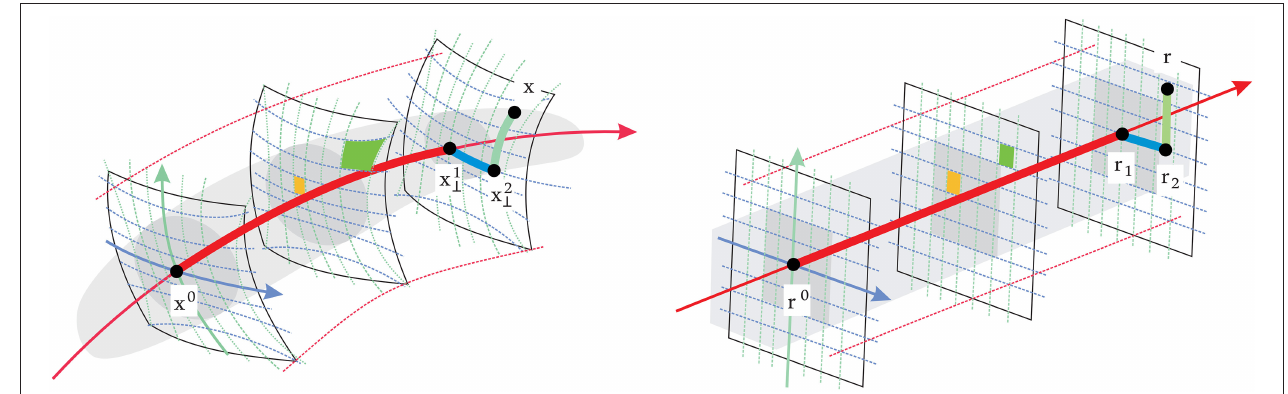
FIGURE 11 | The SPCA leading idea is removing redundancies by unfolding the dataset along the first and secondary Principal Curves (PCs) and performing local equalization along the way. Here the first PC (Hastie and Stuetzle, 1989) is in bold red and the secondary PCs (Delicado, 2001) are in green and blue. Left plot represents the input domain x and right plot represents the response domain r. Gray regions represent the underlying PDFs. As in Self Organizing Maps (Kohonen, 1982), a curvilinear lattice is assumed (thin red, blue, and green curves). However, unlike in SOM, the computation of the whole lattice is not needed: to transform a certain x just the path in bold style, made of segments of PCs, is required. Moreover, the specific resolution per dimension emerges from data: the PDF-based metric in SPCA implies that highly populated regions in the input are expanded in the response while lower density regions are shrunk (e.g., orange and green areas) . Given an origin, x o , in the first PC (red line) and some point of interest, x, the response for the point of interest is given by the lengths along this path: the first PC in red, the secondary PC in blue in the orthogonal subspace at x 1 ⊥ , which is the (geodesic) orthogonal projection of x on the first PC, and the secondary PC in green in the orthogonal subspace at x 2 ⊥